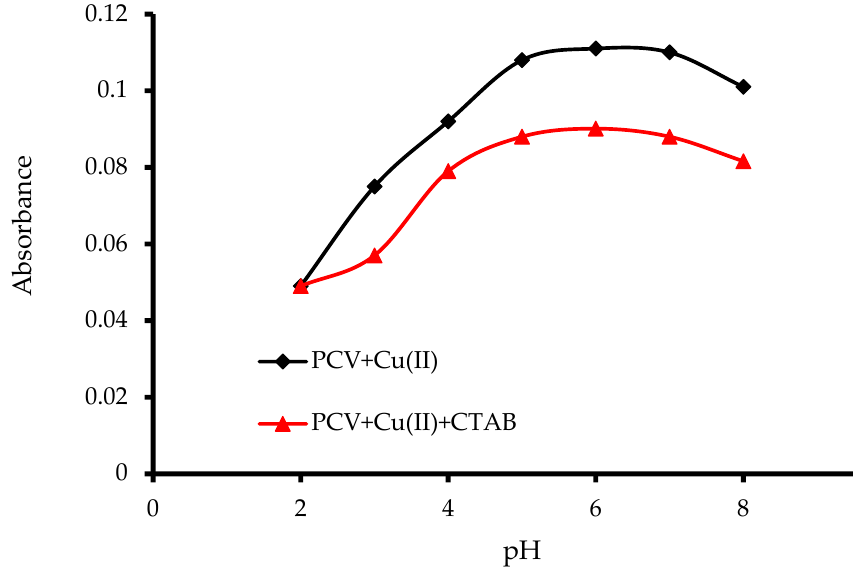
Figure 5. Effect of the solution pH on the absorbance of PCV-Cu (0.1 mmol L −1 each) in the absence and presence of 200 µL of 30 µg mL −1 (8.2 × 10 −2 M) CTAB at a flow rate of 3.5 mL min −1 and 430 nm.